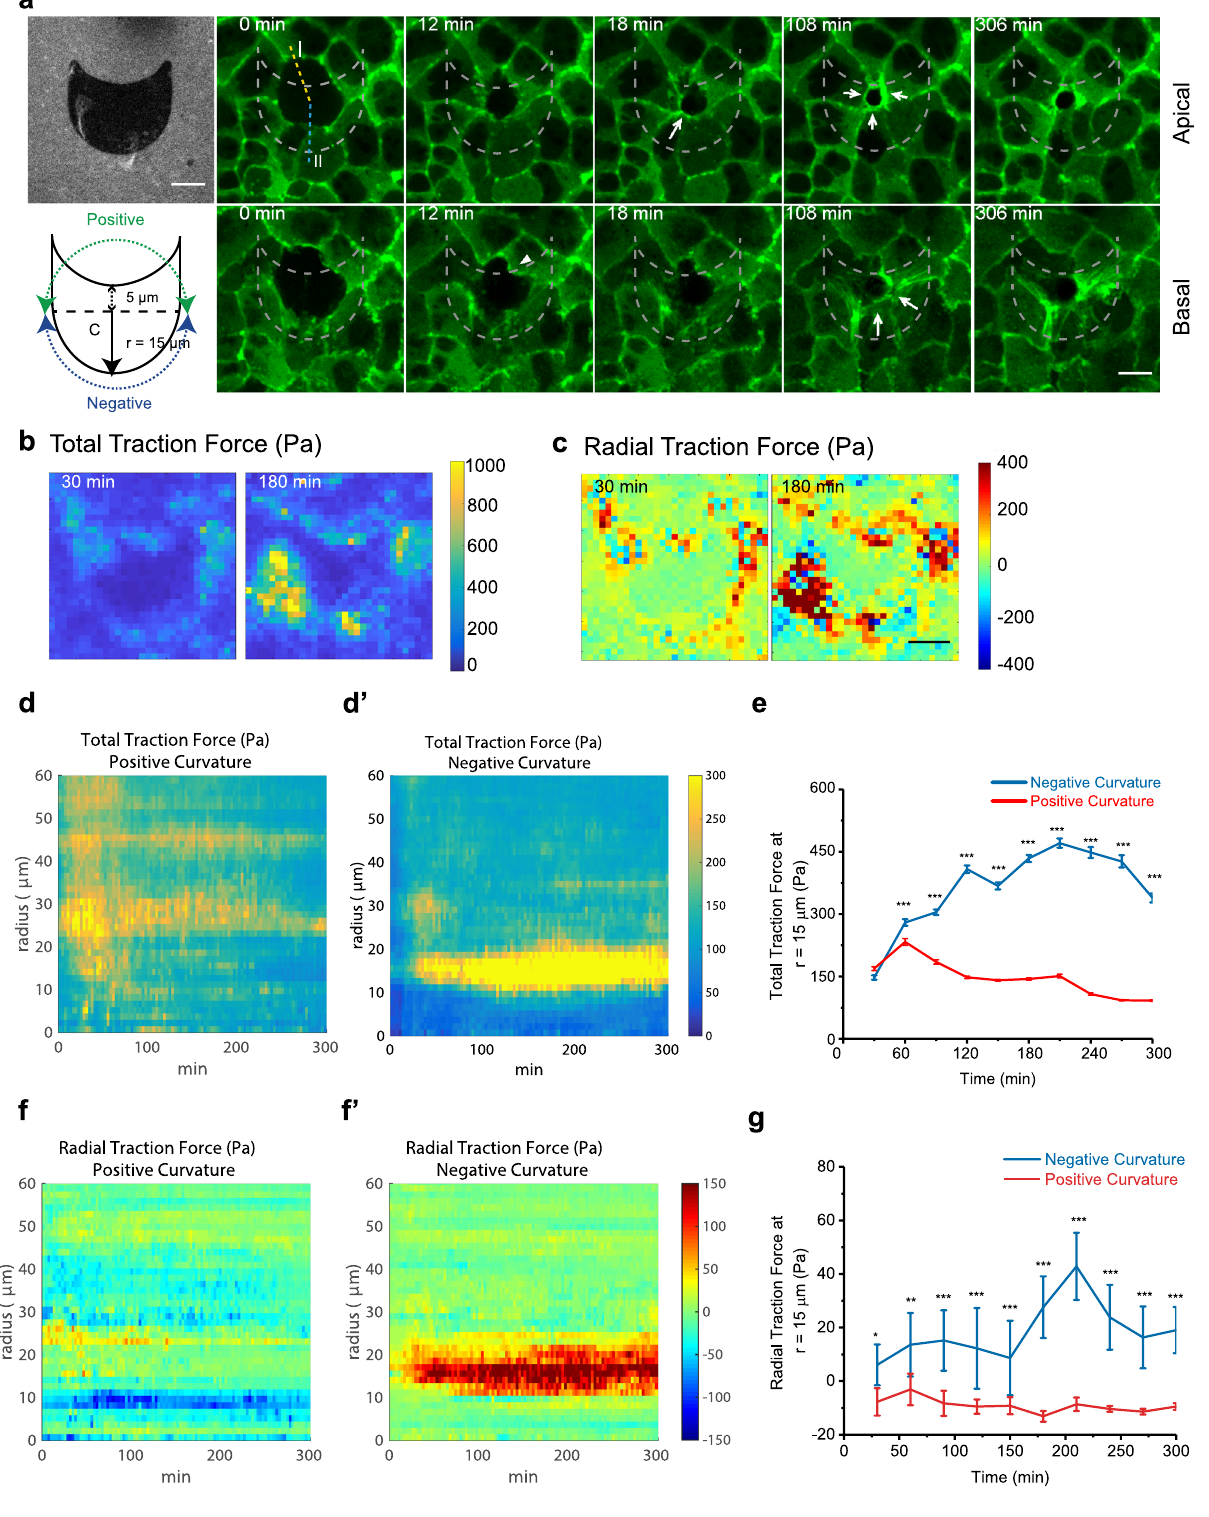
recruit factors organizing actomyosin purse-string like